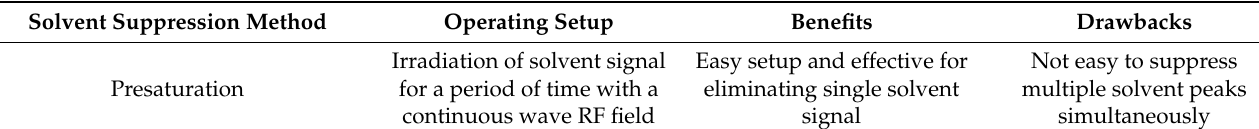
Table 1. The advantage and limitation of the common solvent suppression